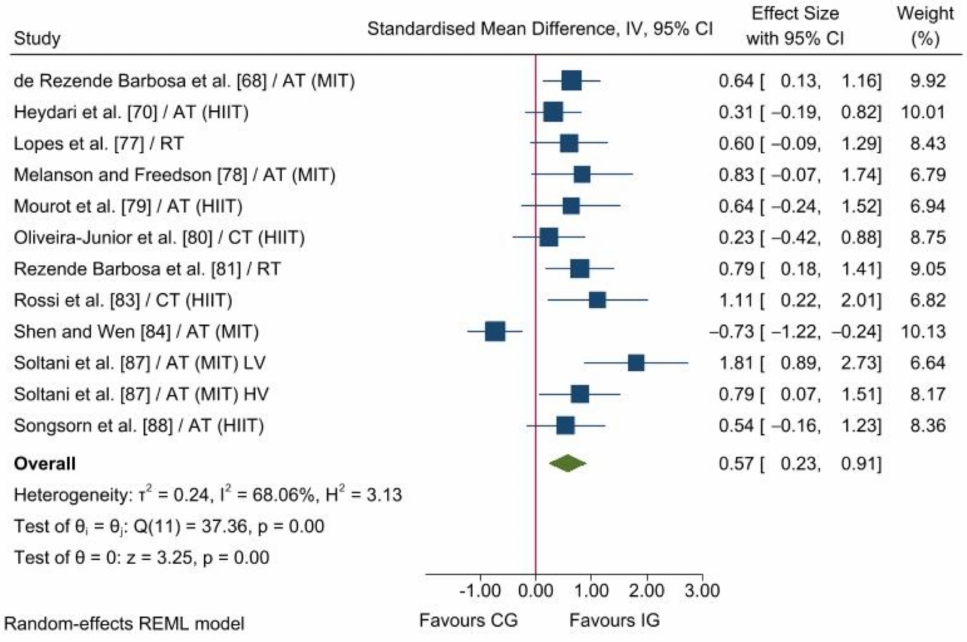
Figure 2. Forest plot of standardised mean difference between the intervention and control groups for RMSSD. AT, aerobic training; CG, control group; CI, confidence interval; CT, combined aero- bic and training; HIIT, high-intensity interval training; HV, high volume; IG, intervention group; IV, inverse variance; LV, low volume; MIT, moderate intensity training; RT, resistance training